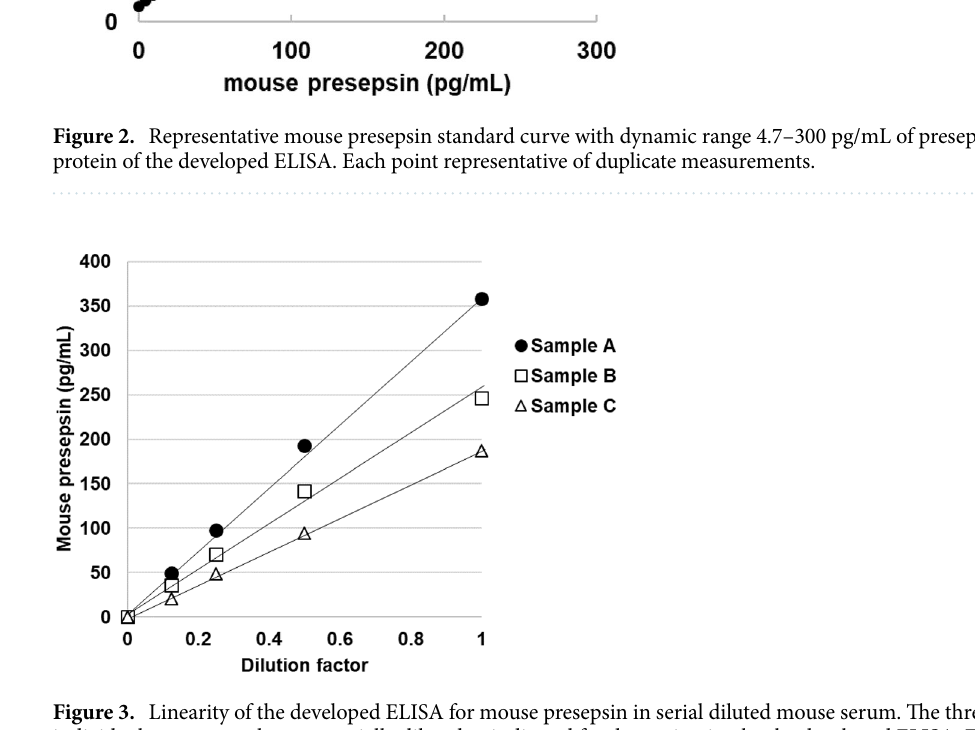
Figure 3. Linearity of the developed ELISA for mouse presepsin in serial diluted mouse serum. The three individual serum samples were serially diluted as indicated for determination by the developed ELISA. Each point representative the mean value of duplicate measurements.